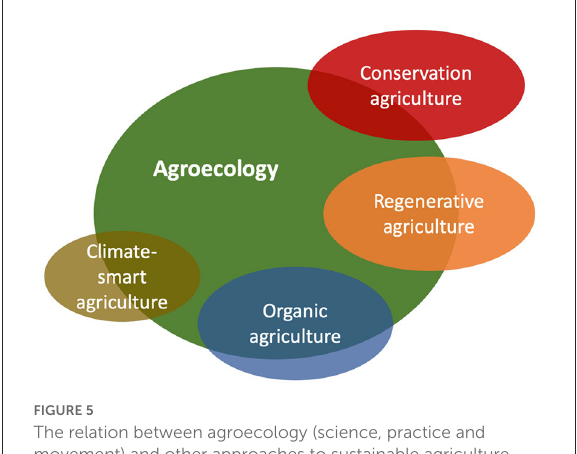
FIGURE5 The relation between agroecology (science, practice and movement) and other approaches to sustainable agriculture, depicting their degree of overlap as intersecting sets. As a scientific discipline, agroecology provides the ecological knowledge that underpins sustainable practices under the other